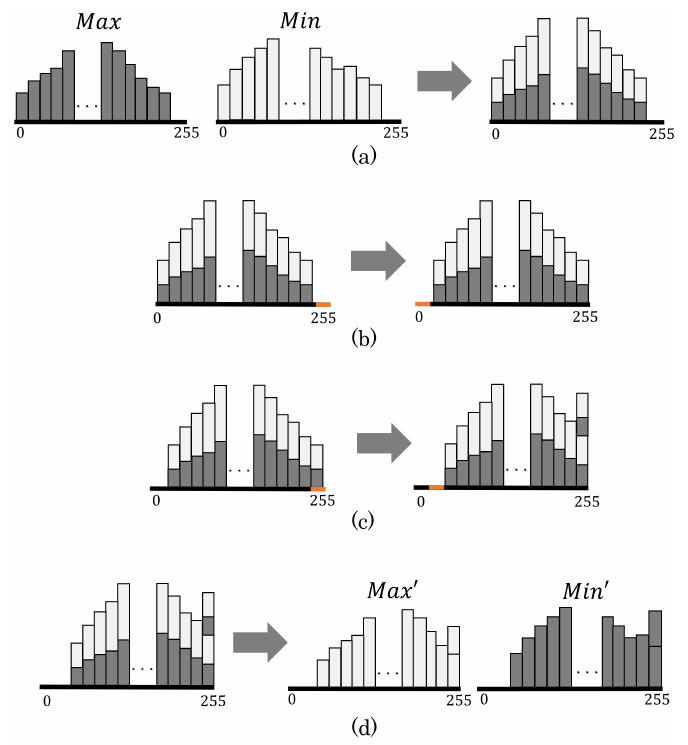
Figure 4. Histogram transition of Max and Min for brightness increase function. ( a ) Raw histograms and integrated histogram of Max and Min ( b ) In case the reference bin is empty. ( c ) In case the reference bin is not empty. ( d ) Separation into Max (cid:48) and Min (cid:48)